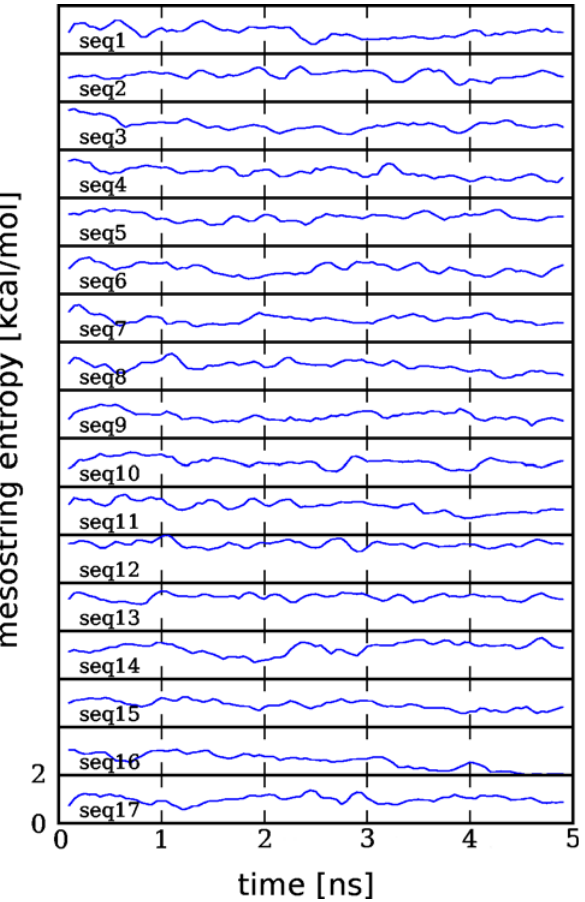
Figure 3. Variation of the Information Entropy of Mesostrings in the 17 Peptides from Protein G The entropy at each point is calculated over a 0.2-ns window. The backbone entropy holds fairly steady after 1 ns. DOI: